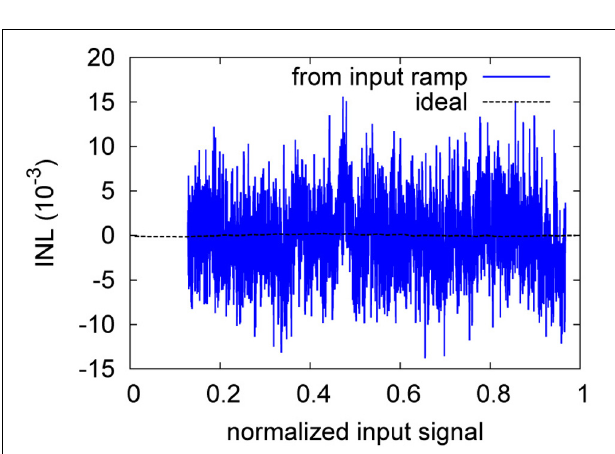
FIGURE 14 | Ideal and ramp-based INL of the baseline of Table 6.